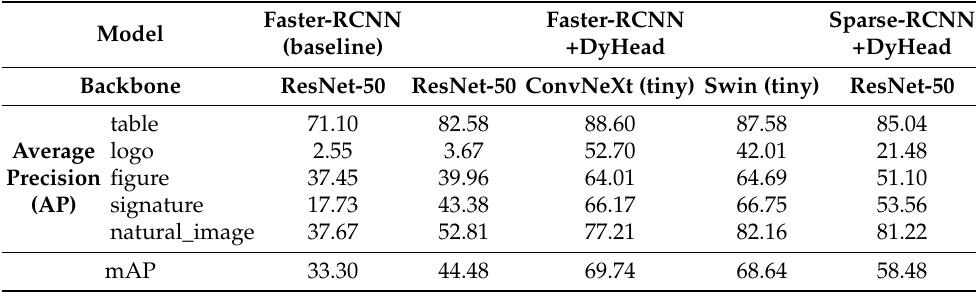
Table 6. Performance evaluations of IIIT-AR-13K using Faster-RCNN with different backbones. Results with Sparse-RCNN using ResNet-50 backbone are also presented. The baseline model fails to achieve robustness with this dataset. Nevertheless, inclusion of DynamicHead improves the mAP score by 11.18 in comparison with baseline, confirming the drastic improvements with attention mechanism. The results are further improved with ConvNeXt backbone with the mAP score roughly double the baseline score, i.e., 33.30 to